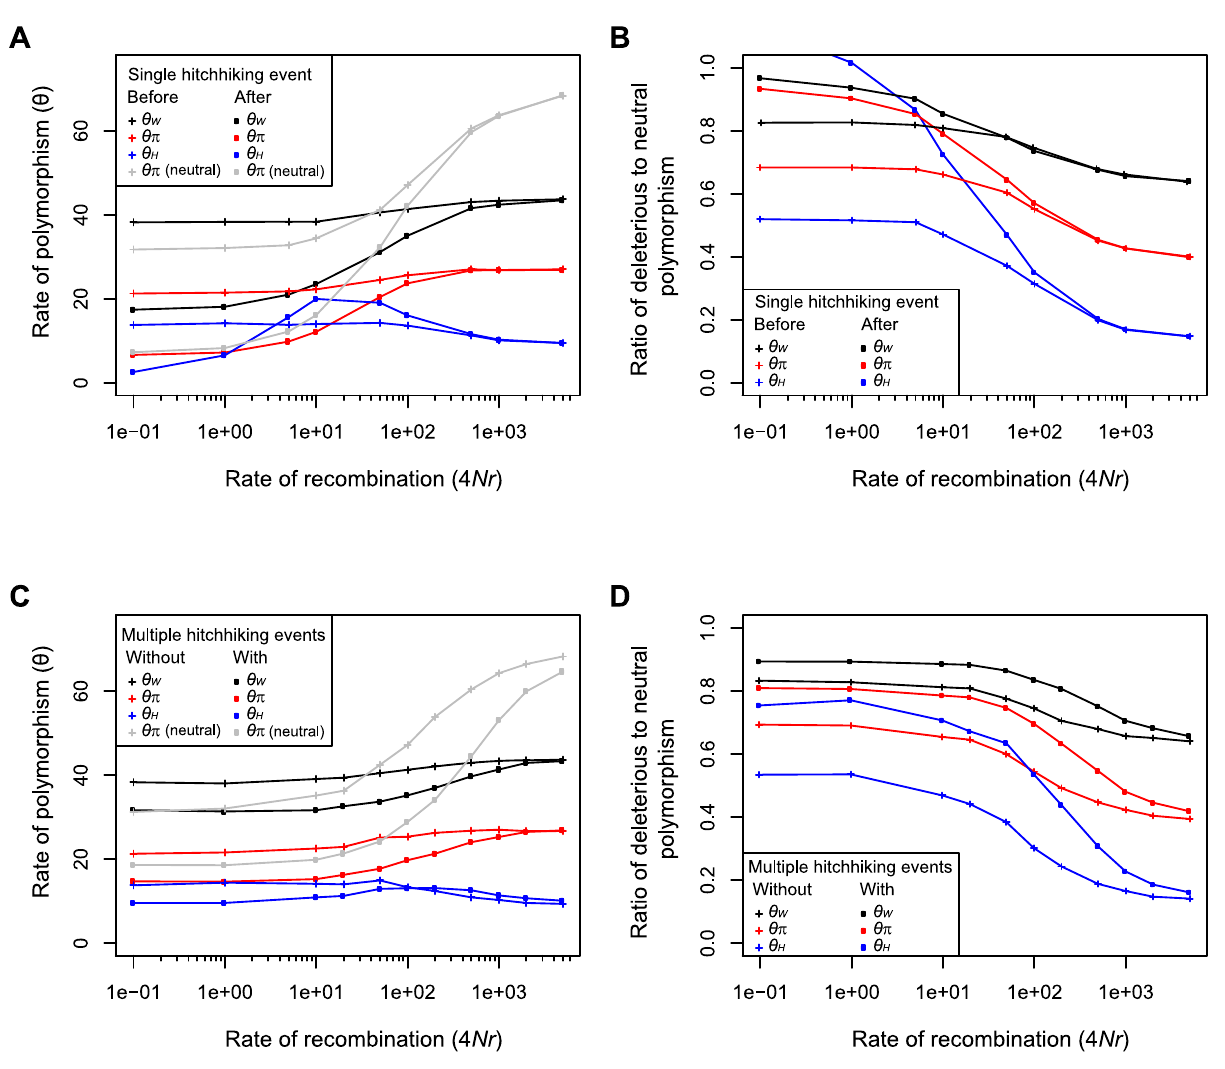
Figure 1. The effect of hitchhiking on neutral and deleterious polymorphism as a function of the rate of recombination. The rate of low, intermediate and high frequency deleterious polymorphism measured by h W (black), h p (red) and h H (blue), respectively, before (crosses) and after (squares) a single hitchhiking event (A) and in the presence (crosses) and absence (squares) of multiple hitchhiking events (C). Average heterozygosity ( h p ) of neutral polymorphism is shown in gray. The ratio of deleterious to neutral polymorphism is shown before (crosses) and after (squares) a single hitchhiking event (B) and in the absence (crosses) and presence (squares) of multiple hitchhiking events (D). All panels show the mean of 500 simulations for which 4 Nu n =70, 4 Nu d =70, 4 Ns d = 2 10 and 4 Ns a =100, where N is the population size, u is the mutation rate, s is the selection coefficient, and subscripts n , a and d refer to neutral, advantageous and deleterious mutations. In panel A and B, a single hitchhiking event occurs at the center of the chromosome. In panel C and D, 4 Nu a =0.5 and multiple hitchhiking events occur across the entire chromosome.